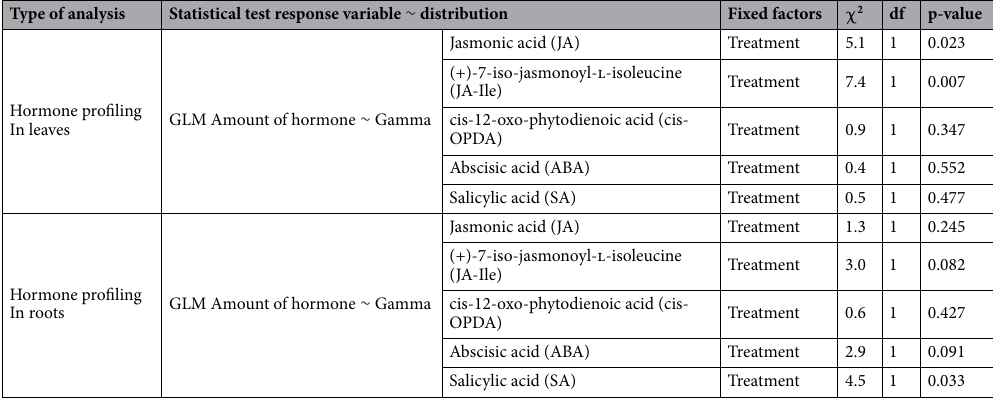
Table 1. Summary of models of Experiment 2 showing type of test and distribution, used and results for the fixed factors.